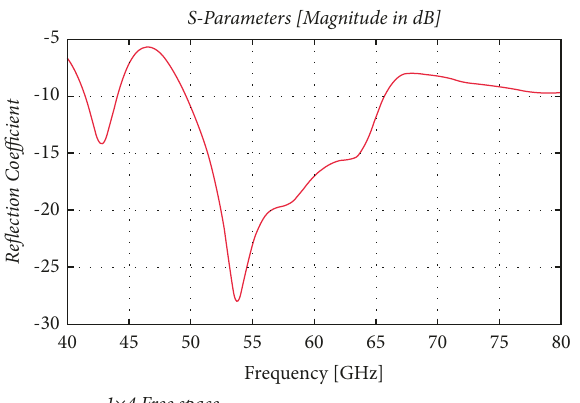
Figure 18: Return Loss of the 1 × 4 antenna array.